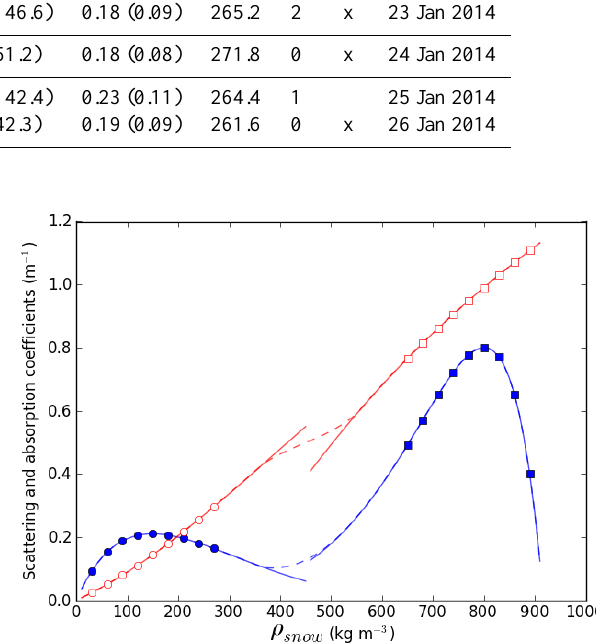
Figure 3. Absorption (red) and scattering (blue) coefficients as a function of ρ snow at 37GHz ( T snow = 260K, T soil = 270K, SD = 1.0m and R eff = 0 . 3mm). The dotted lines show the bridg- ing implementation for an ice fraction between 0.4 and 0.6.